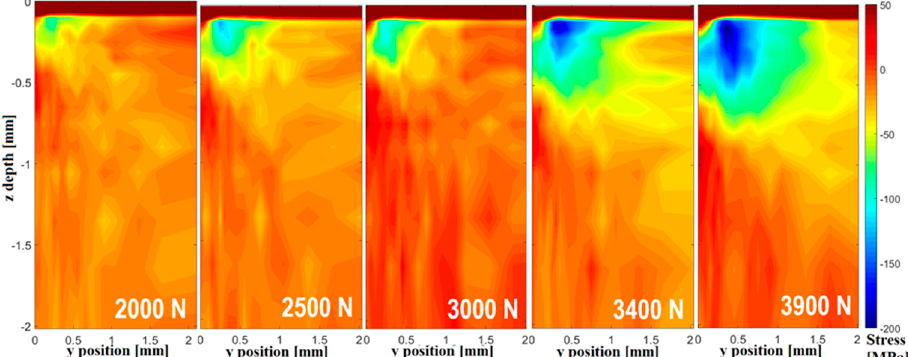
Figure 7. Longitudinal residual stress maps (half fields) for σ yy ( y , z ) after unloading with 5 forces.